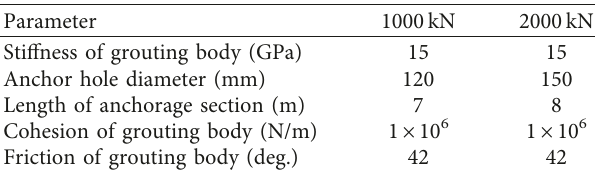
Table 5: Parameters of the